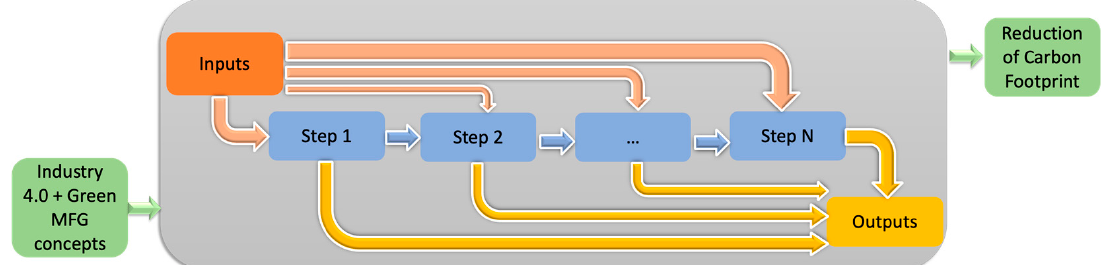
Figure 1. Schematic representation of the steps (blue box) within the production line (grey box) that have been identified, along with list of inputs (orange box) and outputs (yellow box). Outside the production line, the framework identifies which concepts from Industry 4.0 and green manufacturing (left, green box) should be introduced and how they will impact on the carbon footprint (right, green box) once they have been introduced in the production.